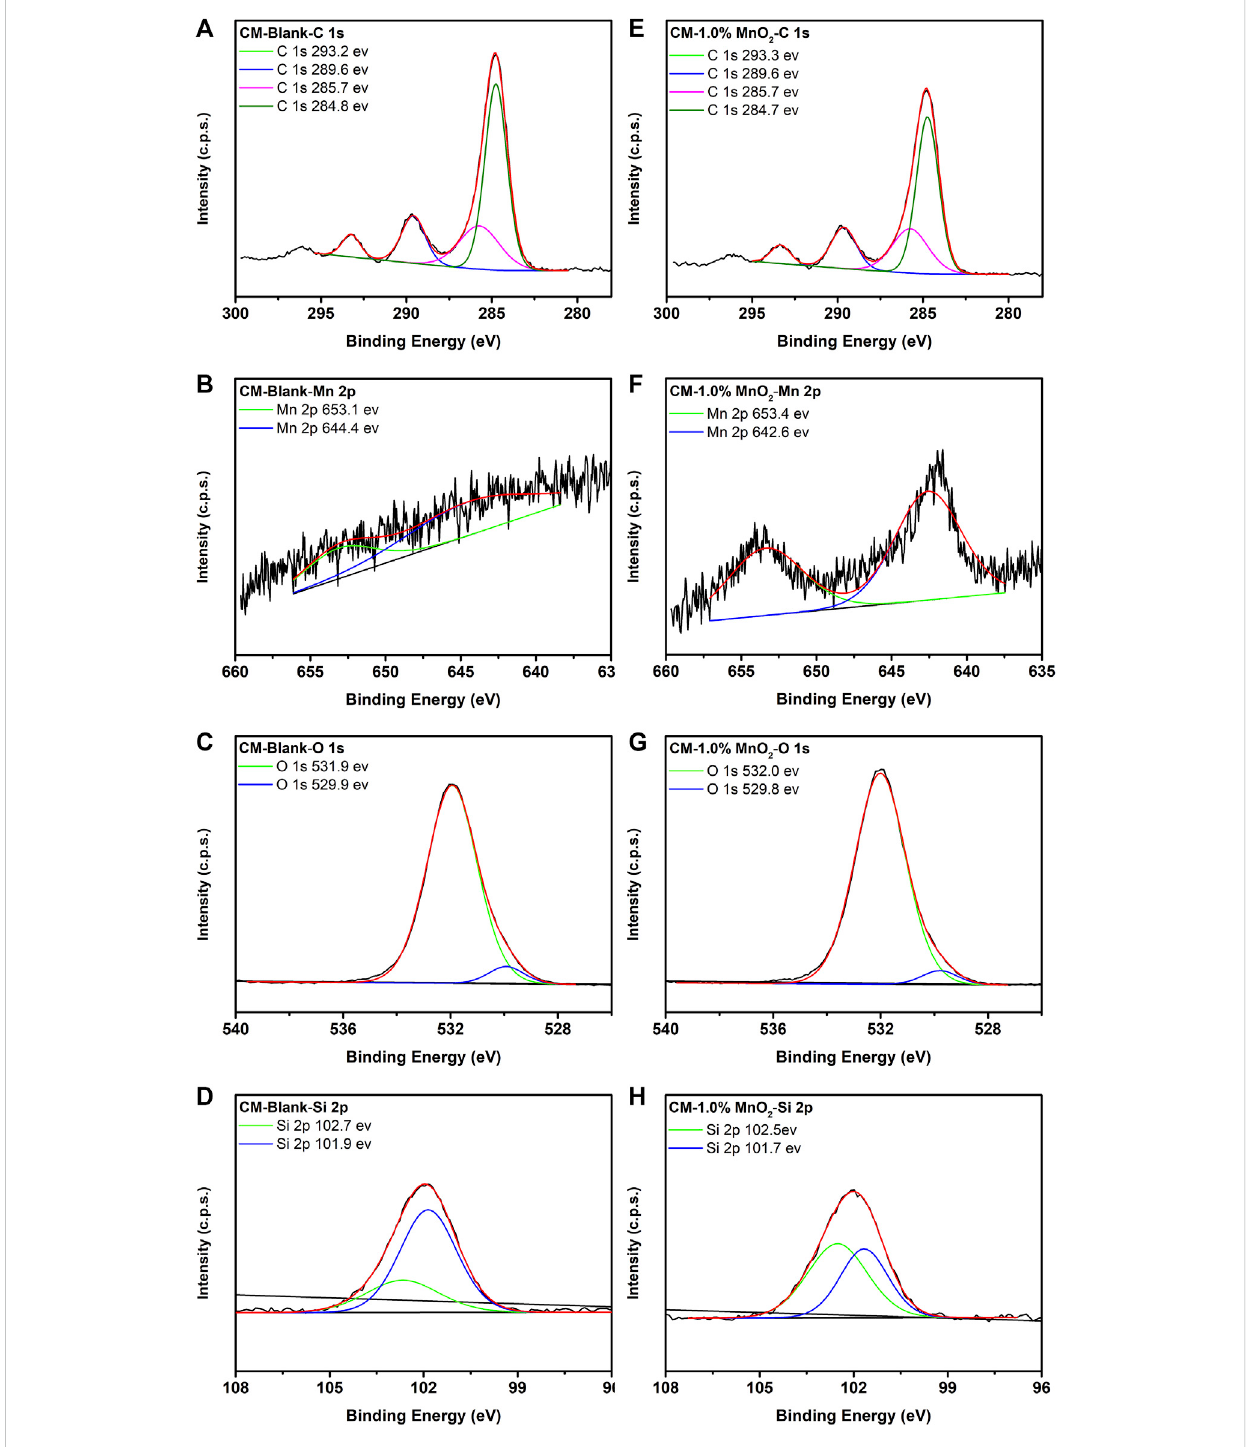
FIGURE 3 The XPS spectra of C 1s, Mn 2p, O 1s, and Si 2p for blank (A − D) and 1% Mn doped CM samples (E − H) .